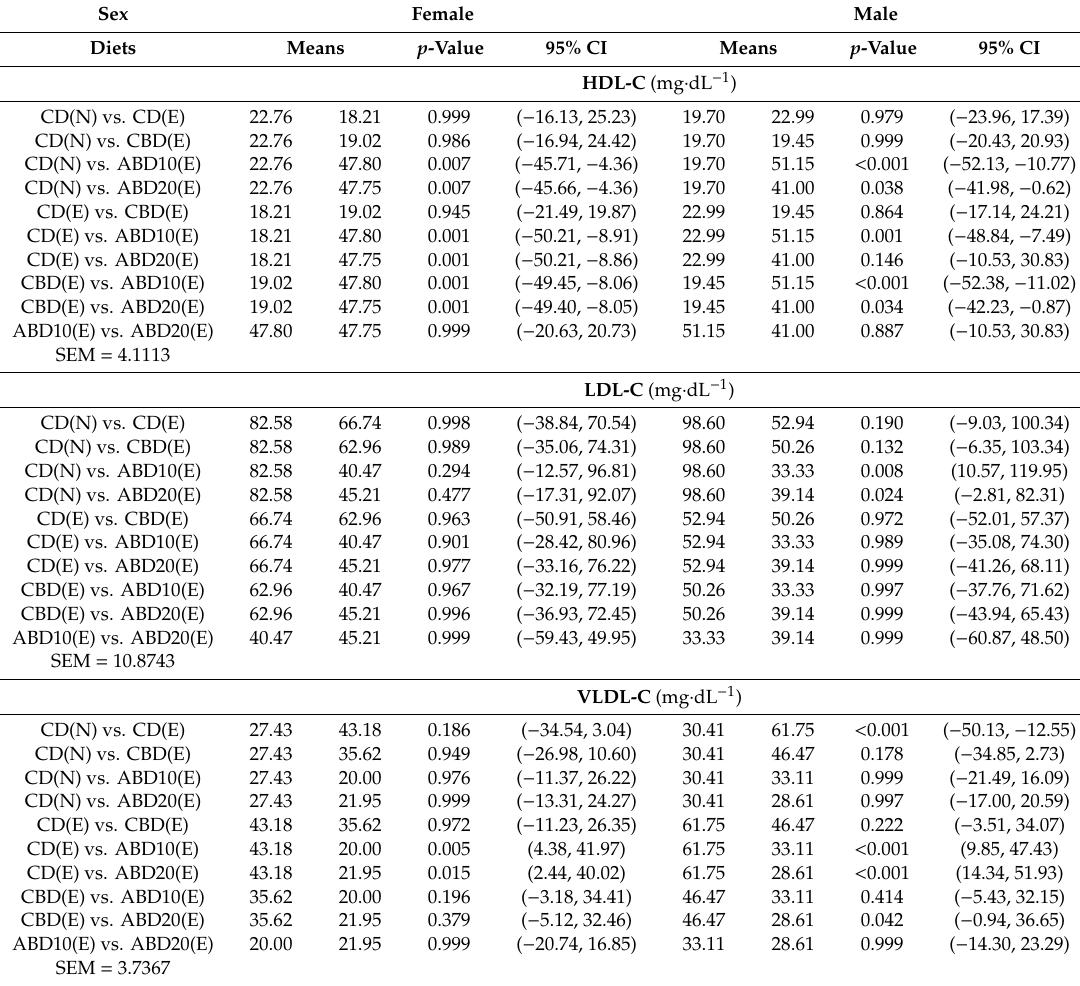
Table 5. E ff ect of 8-week consumption of diets prepared with bread of amaranth on serum high-density lipoprotein (HDL-C), low-density lipoprotein (LDL-C) and very low-density lipoprotein (VLDL-C) in rats (weeks 23 to 31 of